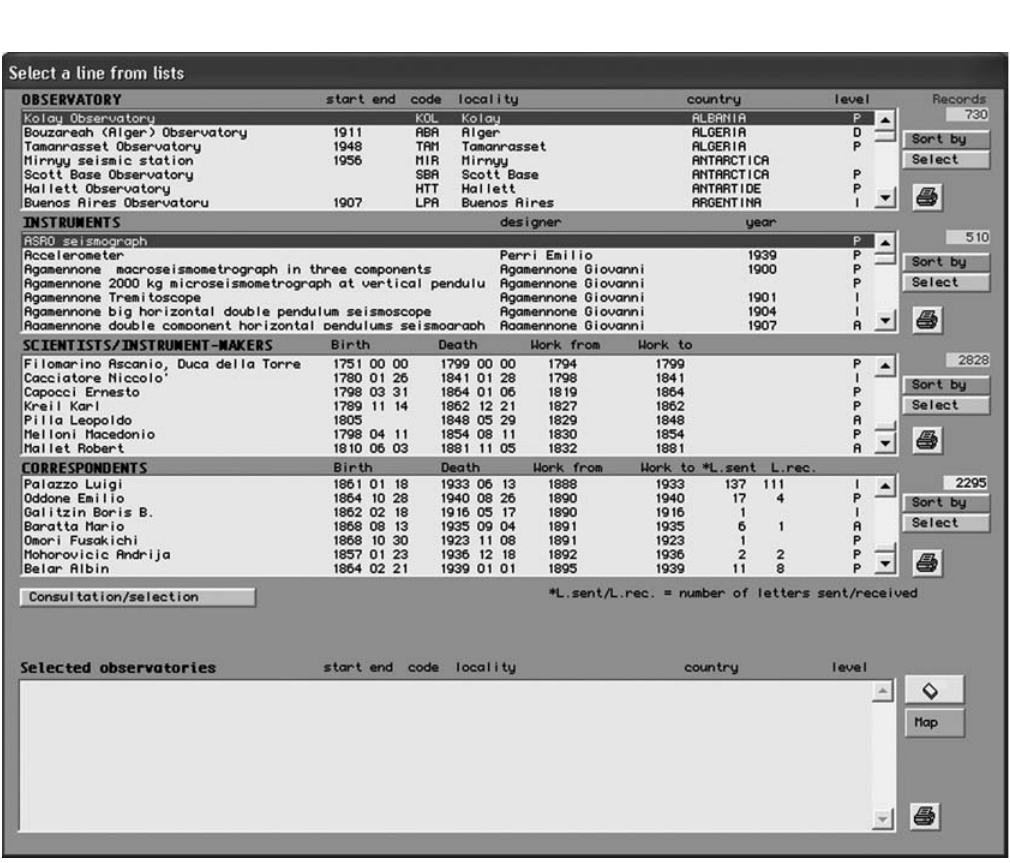
Fig. 2. The main consultation window of the TROMOS database contains four lists with summary information: observatories, instruments, scholars/builders/associations, epistolary correspondents catalogued in the database. A fifth list, at the bottom, is dedicated to collecting a selection of observatories, activated by double-clicking one ach line of interest of the observatories list, following activation of the button: «Consultation/selection». A click on the button «Map» allows us to create a map with the localisation of the selected observatories. Double-click- ing on each line of the list activates a specific detail